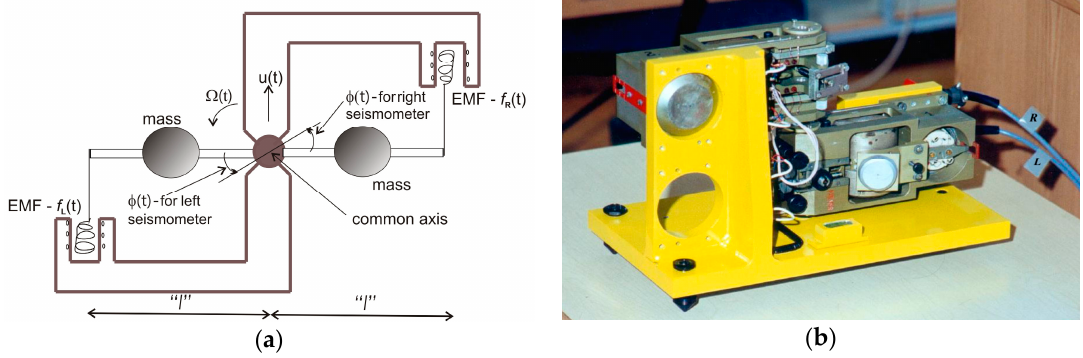
Figure 3. The TAPS rotational seismometer: ( a ) scheme [50]; ( b ) general view. φ (t) is the angle of rotation for a given pendulum.